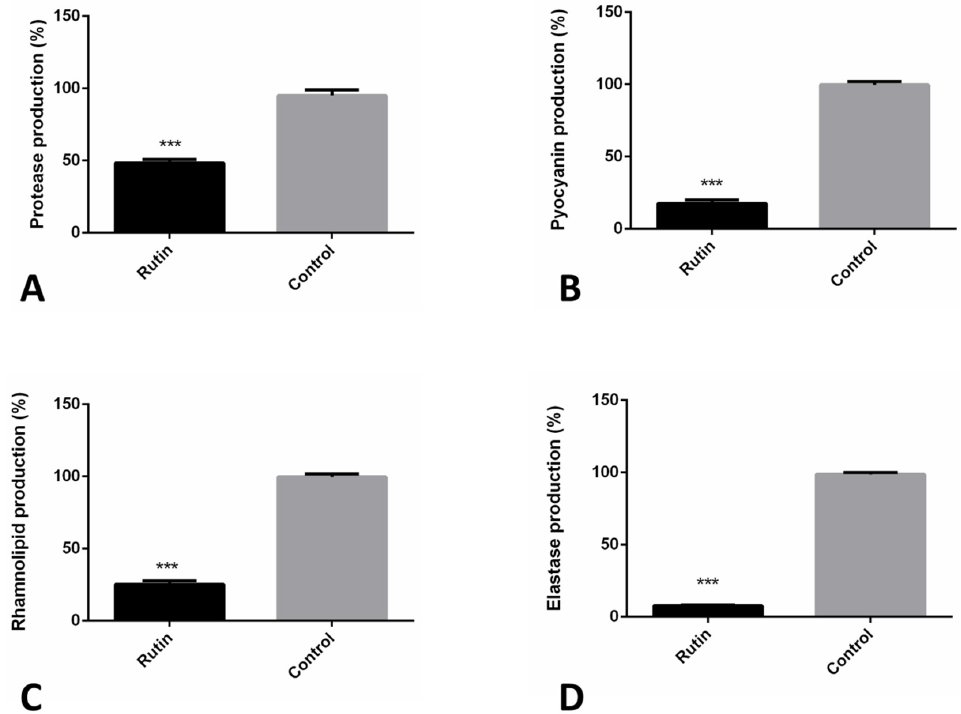
Figure 6. Rutin (0.5 MIC, 0.250 mg/mL) antivirulence mechanisms towards P. aeruginosa IBRS P001: impact on protease ( A ); pyocyanin ( B ); rhamnolipid ( C ) and elastase ( D ) production. The asterisks represent statistical significance ***, p ≤ 0.001; the data are presented as mean ± SD.